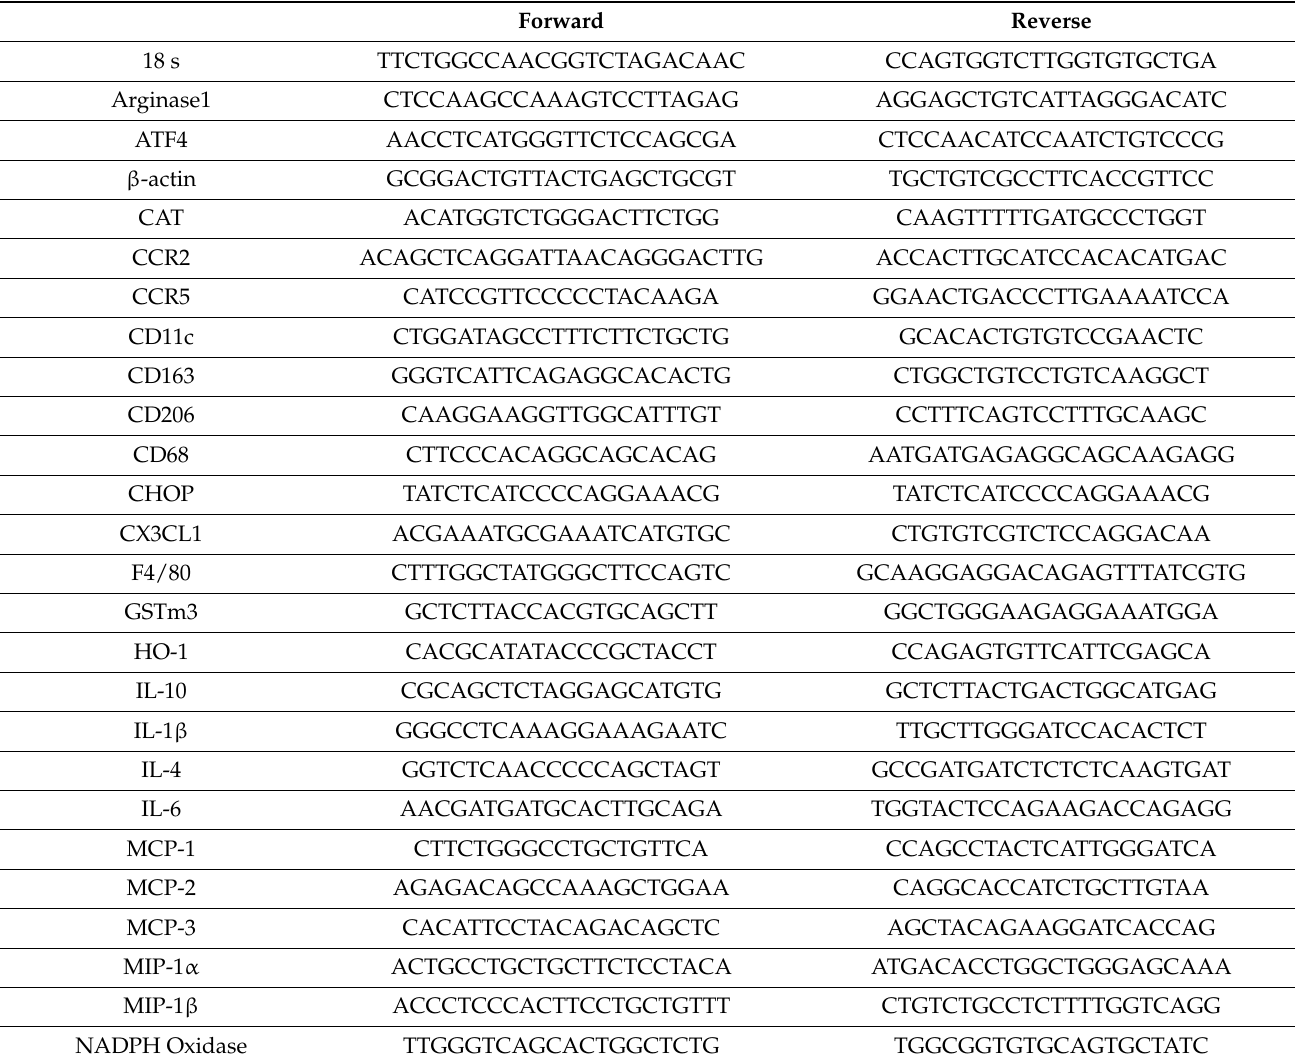
Table 1. Primer sequences for Real